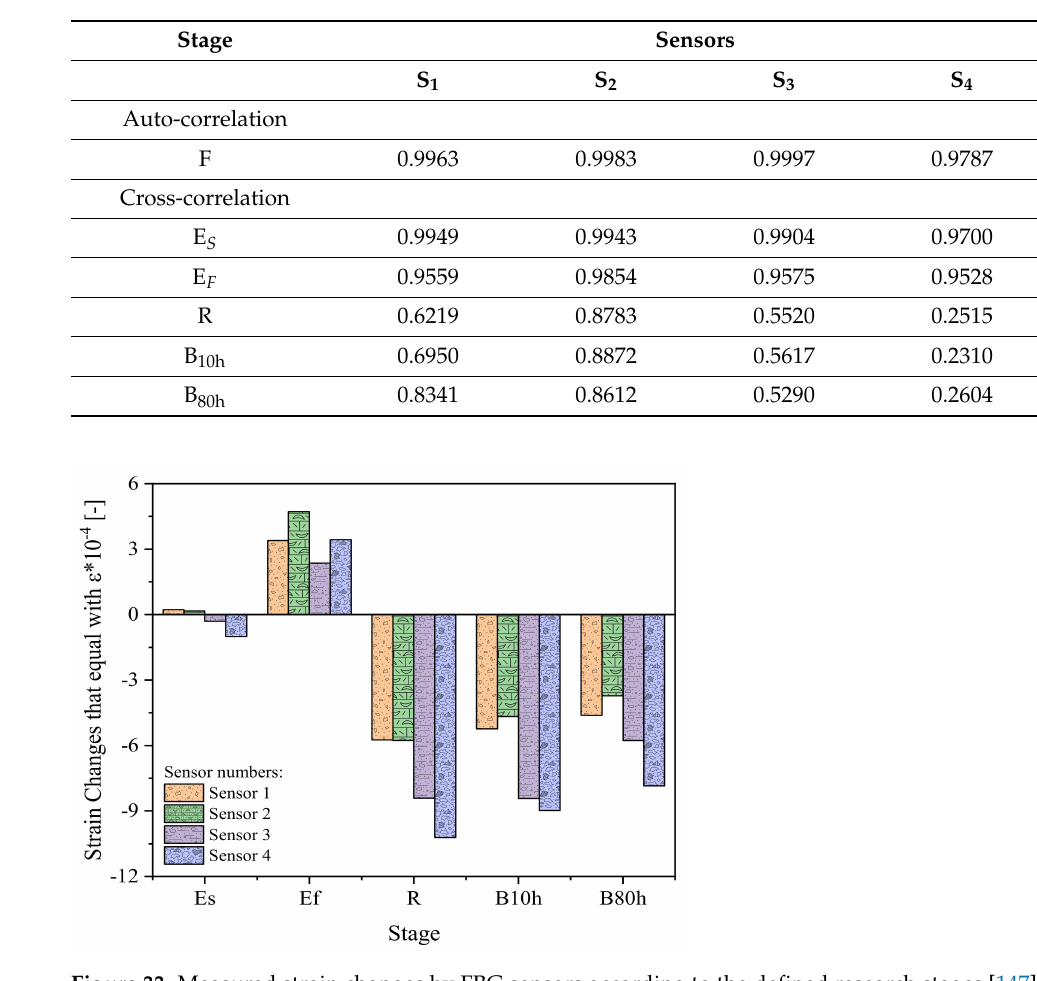
Table 13. Calculated Pearson’s correlation coefficients [147].